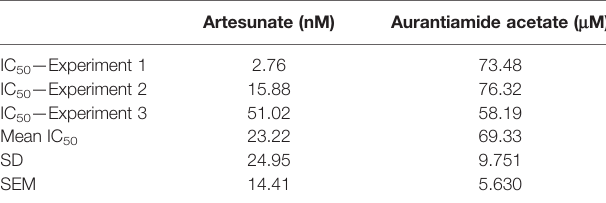
TABLE 4 | IC 50 values of artesunate and aurantiamide acetate for the synchronized culture of Plasmodium falciparum 3D7 ring stages.